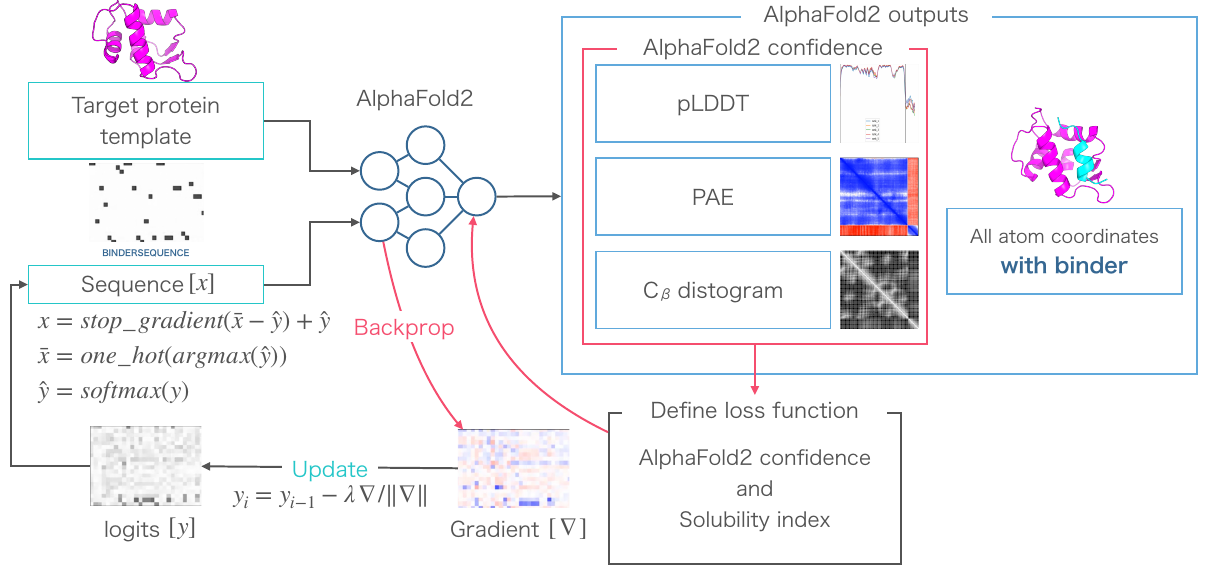
Figure 1. Schematic of the optimization method of the AfDesign binder hallucination. The output of AlphaFold is an all-atom coordinate, two reliability indices (predicted aligned error (PAE) and predicted local-distance difference test (pLDDT)), and a distogram. These are used to define the loss function, which is back-propagated to compute the gradient for the design sequence and then updated and predicted in a loop for optimization. To evaluate the optimized sequence, the binding affinity is calculated by docking and logS is calculated as a peptide solubility